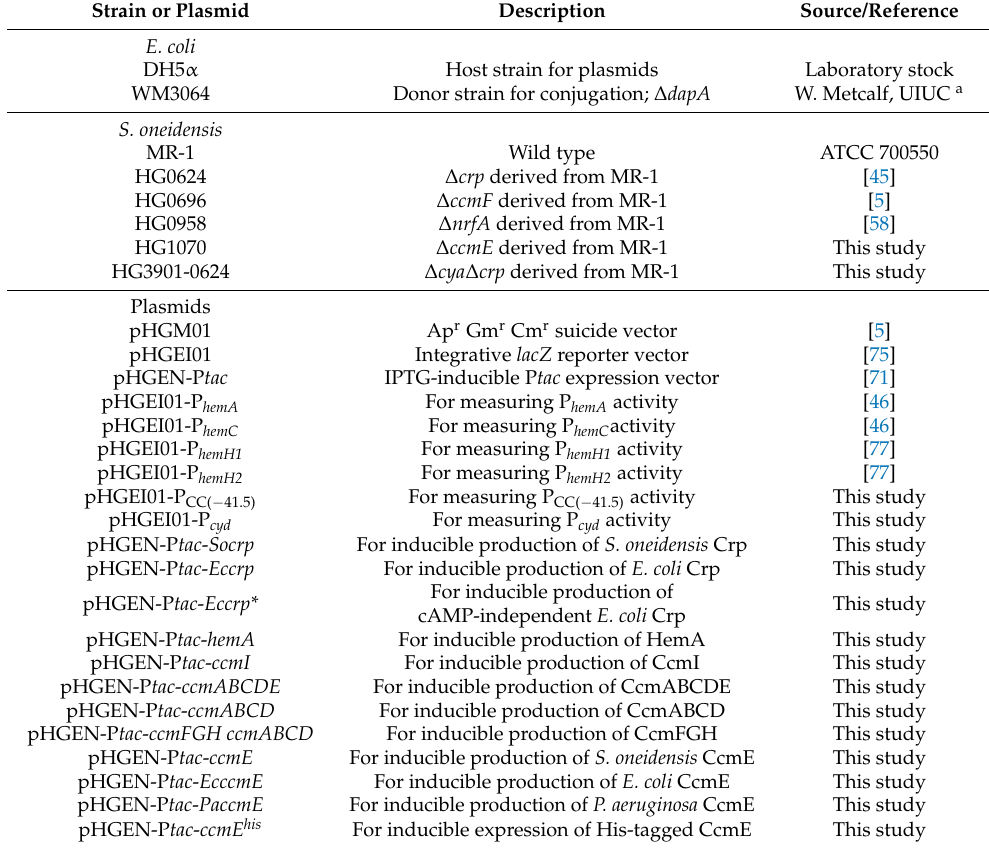
Table 1. Strains and plasmids used in this